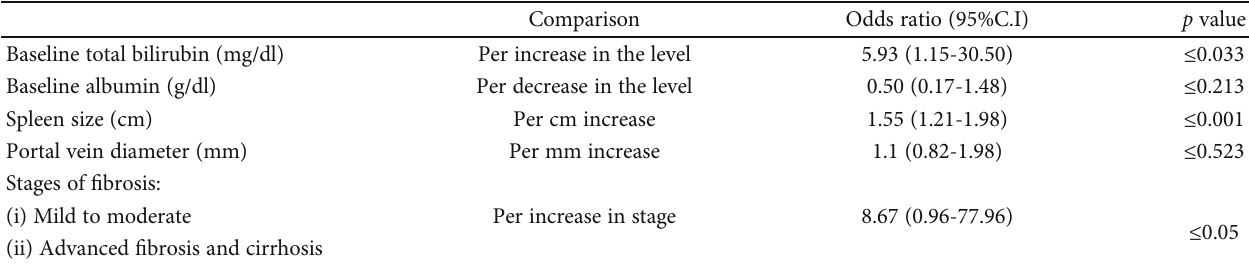
Table 7: Multivariate analysis of risk factors that hinder improvement in platelet